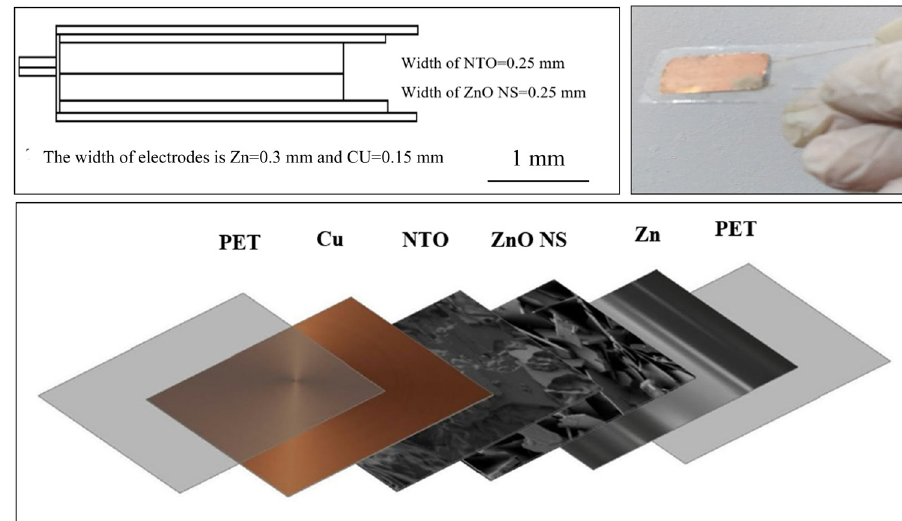
Figure 1: Construction of ZnO NSs – NTO